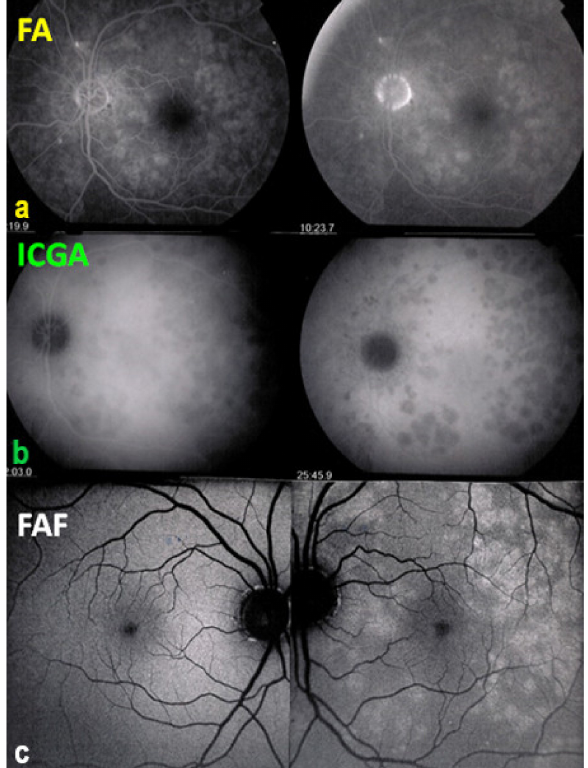
Figure 7. Multimodal imaging of a case of MEWDS. FA ( a ) shows faint FA hyperfluorescence probably caused by outer retinal ischaemia. ICGA ( b ) shows extensive zones of hypofluorescence due to choriocapillaris non-perfusion. FAF ( c ) shows extensive BAF hyperautofluorescence that co-localise with ICGA hypofluorescent areas and is produced by the loss of the photopigment screen unmasking the normal underlying RPE autofluorescence.